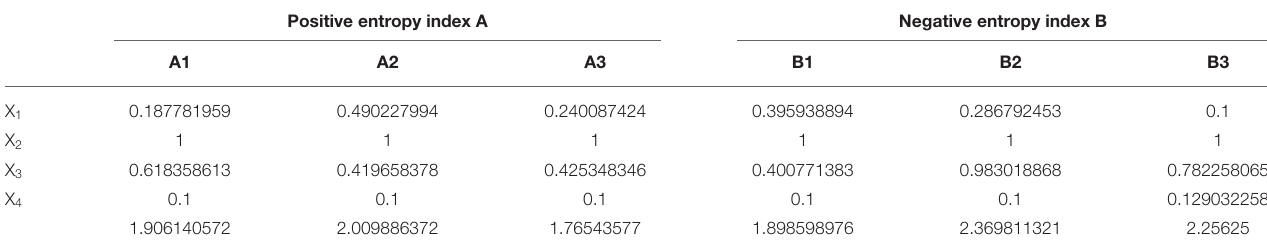
TABLE 3 | Normative values of positive and negative entropy index.